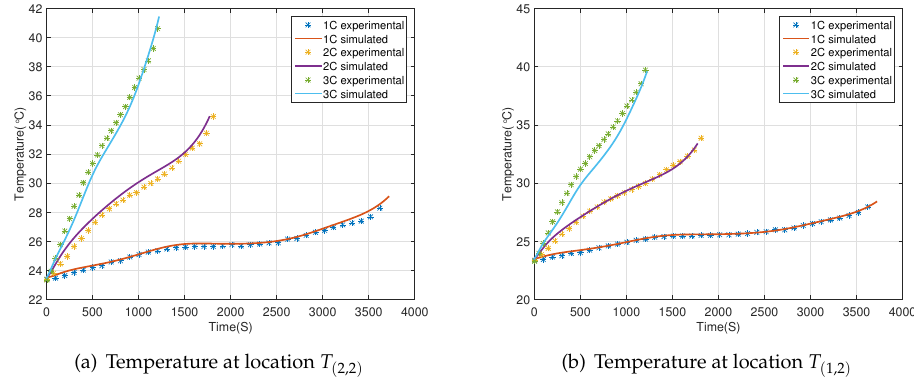
Figure 12. Temperature validation at different discharge